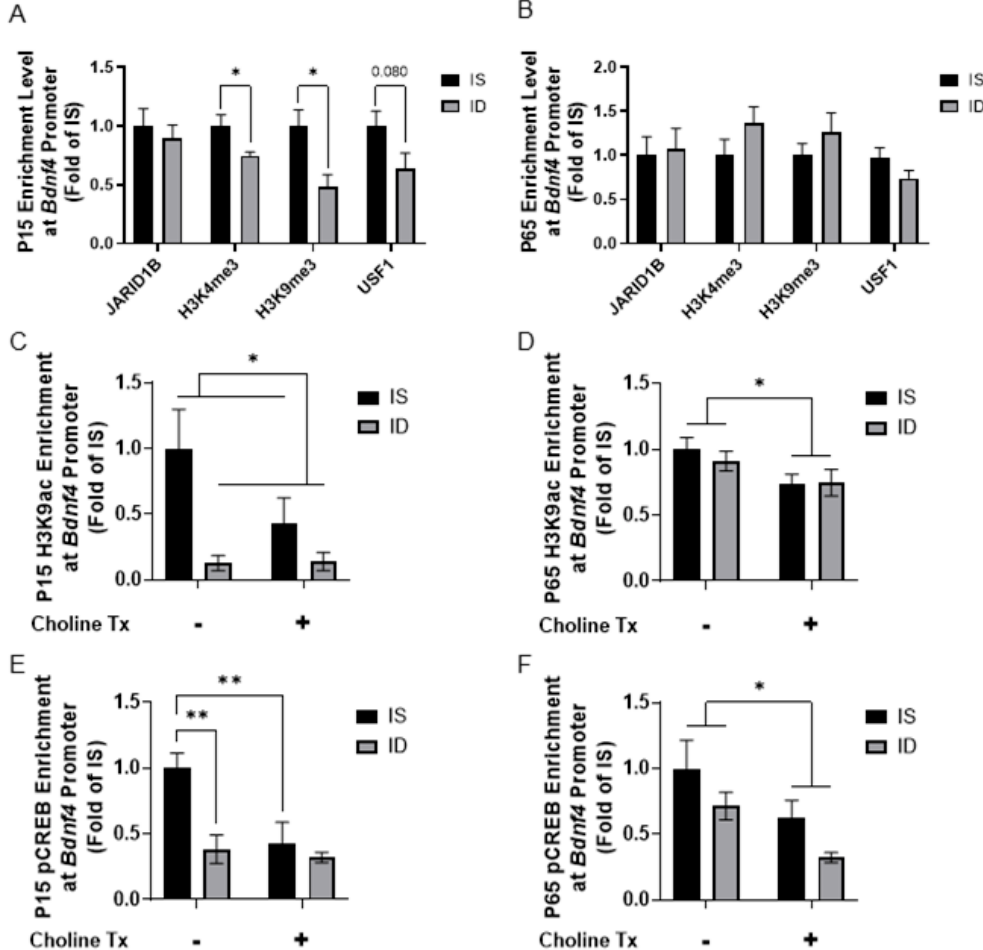
Figure 5. Iron deficiency and choline supplementation induce epigenetic changes at the hippocampal Bdnf4 promoter. ( A , B ) Enrichment levels of JARID1B, H3K4me3, H3K9me3 and upstream stimulatory factor 1(USF1) at the Bdnf4 promoter in P15 ( A ) and P65 ( B ) IS and ID groups. ( C , D ) H3K9ac enrichment at the Bdnf4 promoter in the 4 groups at P15 ( C ) and P65 ( D ). ( E , F ) pCREB enrichment at the Bdnf4 promoter in the 4 groups at P15 ( E ) and P65 ( F ). All data were assessed by qChIP and normalized to the age-matched IS group. Tx: Treatment (Supplementation). Values are mean ± SEM; n = 5–6/group; * p < 0.05, ** p <